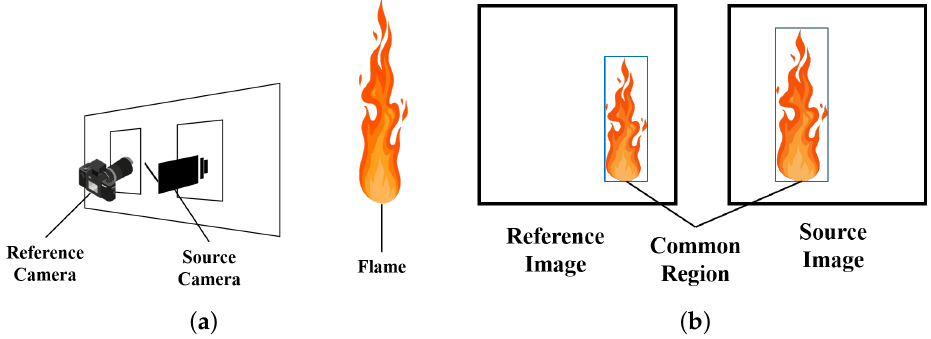
Figure 3. The sketch of online calibration of digital camera for pyrometry. ( a ) Reference Camera and Source Camera; ( b ) Reference Image and Source